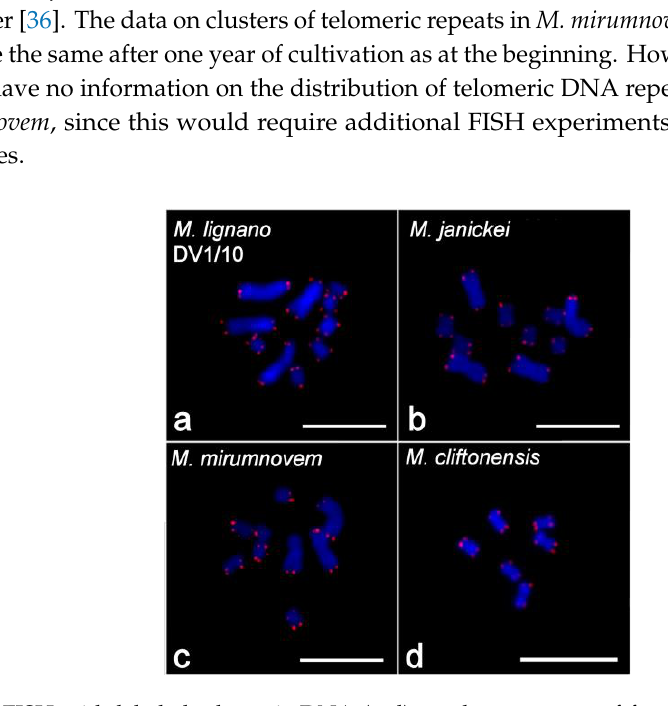
Figure 5. FISH with labeled telomeric DNA (red) on chromosomes of four Macrostomum species: ( a ) M. lignano , ( b ) M. janickei , ( c ) M. mirumnovem , and ( d ) M. cliftonensis . Chromosomes were counter-stained with DAPI (blue). Scale bar 10 µm.